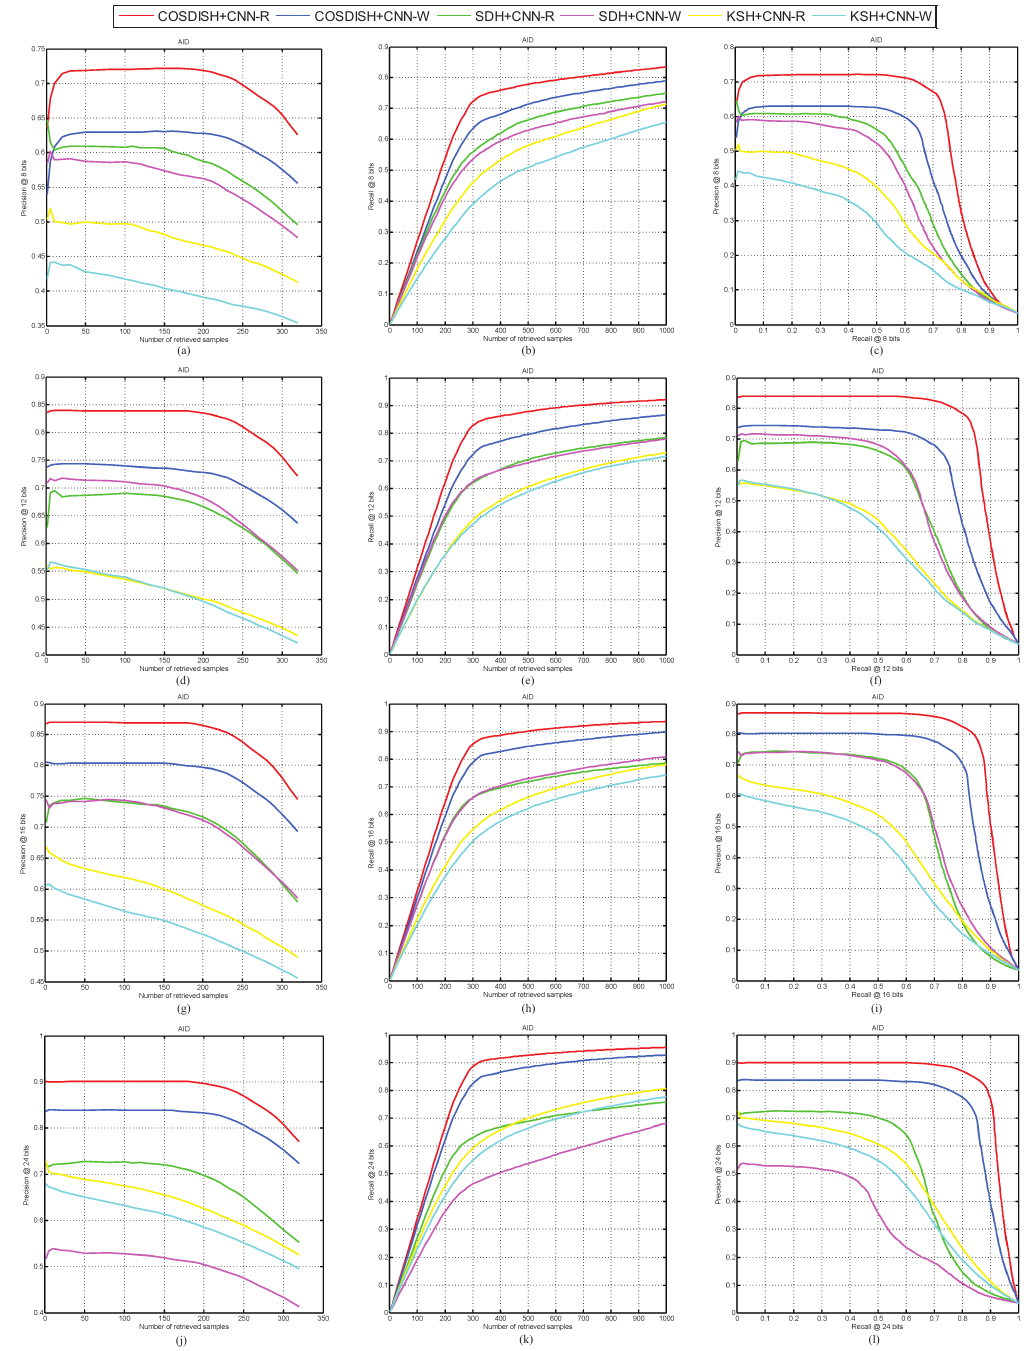
Figure 6. The comparison of precision@K, recall@K and precision-recall curves for different hashing methods with varied CNN features and code length on AID dataset (( a – c ) for 8-bits; ( d – f ) for 12-bits; ( g – i ) for 16-bits; ( j – l ) for